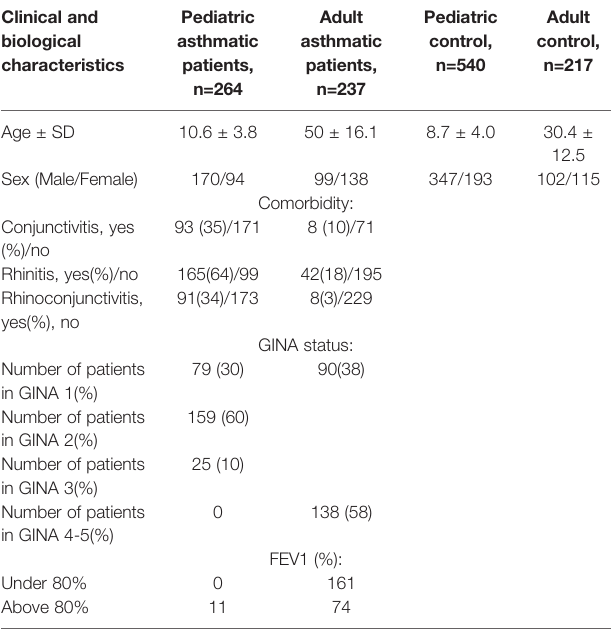
TABLE 2 | Characteristics of the stage II replication